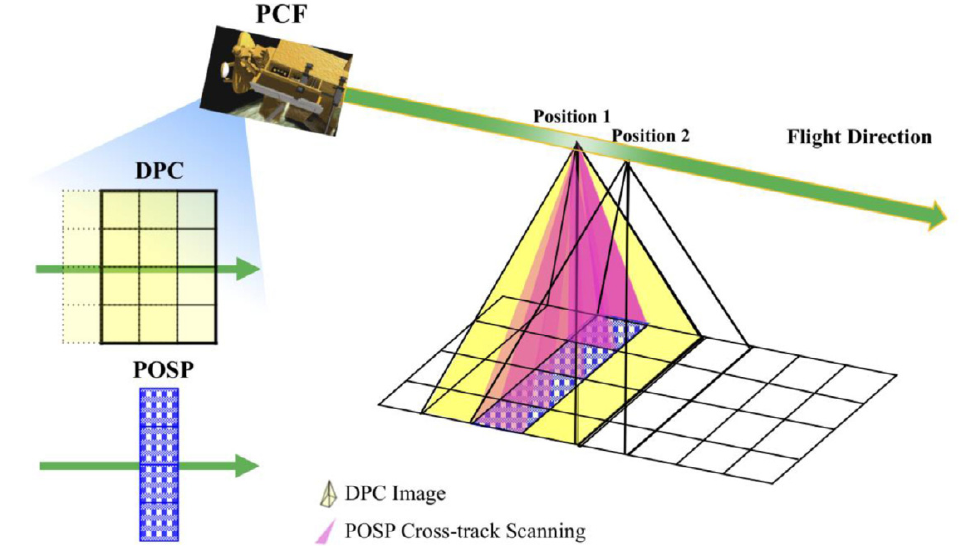
Figure 3. The sampling schematic diagram of PCF [27].